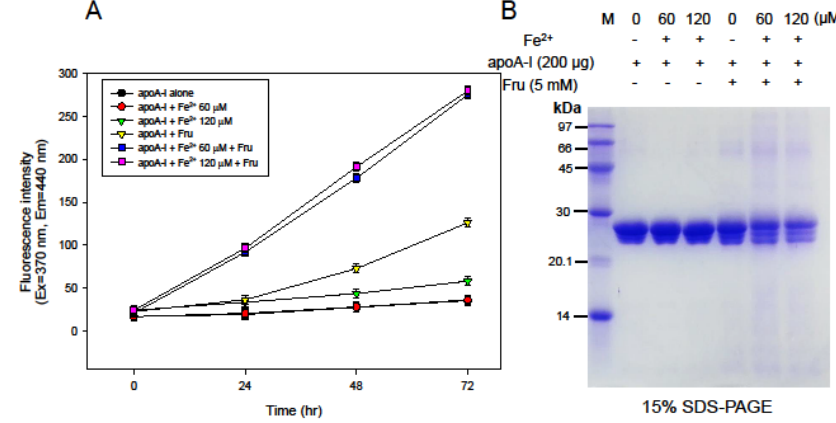
Figure 3. Treatment with Fe 2+ to apoA-I with or without fructose for induction of glycation. ( A ) Production of glycated end products based on detection of fluorescence (Ex = 370 nm, Em = 440 nm); ( B ) Electrophoretic patterns of Fe 2+ -treated apoA-I after 72 h of incubation depends on ferrous ion